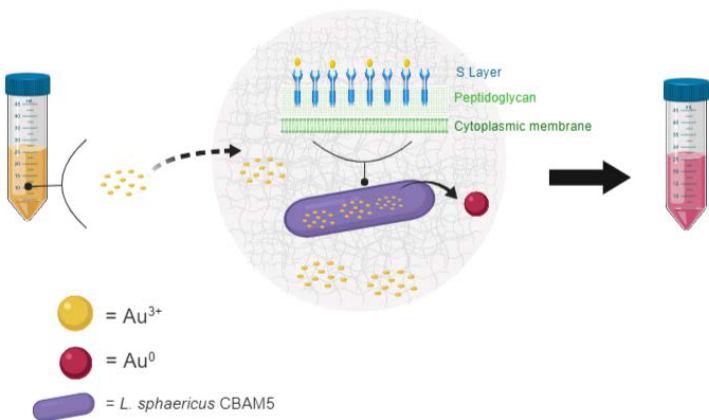
Figure 6. Scheme indicating the main processes that may occur in the encapsulated cells after exposure to Au(III): adsorption through the S-layer, absorption and accumulation inside the bacterial cell and inside the alginate matrix. A possible gold nanoparticles biosynthesis was observed.